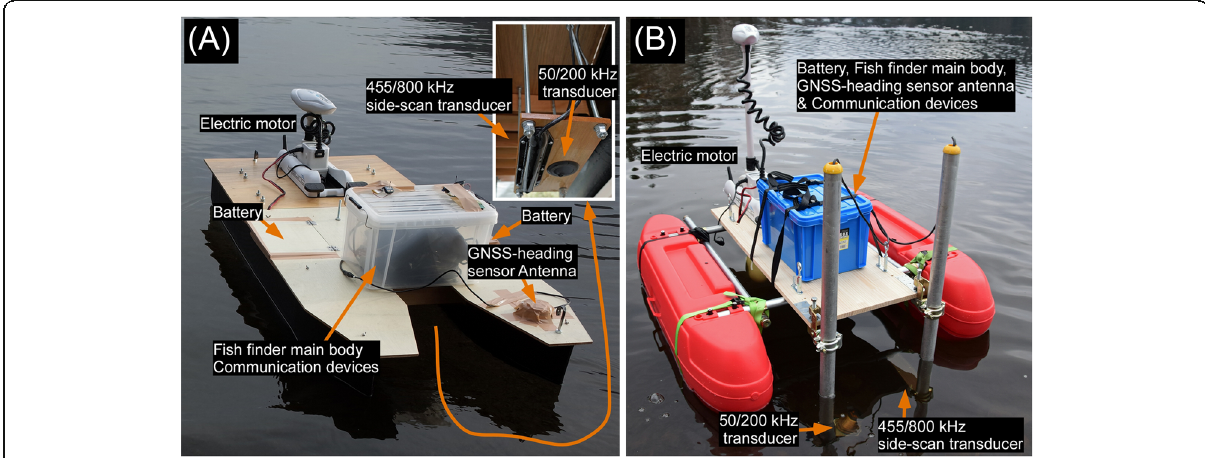
Fig. 3 The developed twin-hulled watercraft: a a model made with a wood frame and waterproof plastic sheets and b a model made with plastic floats, a wood platform, and steel